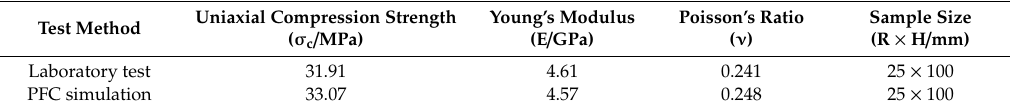
Table 3. Experimental data and simulation results.